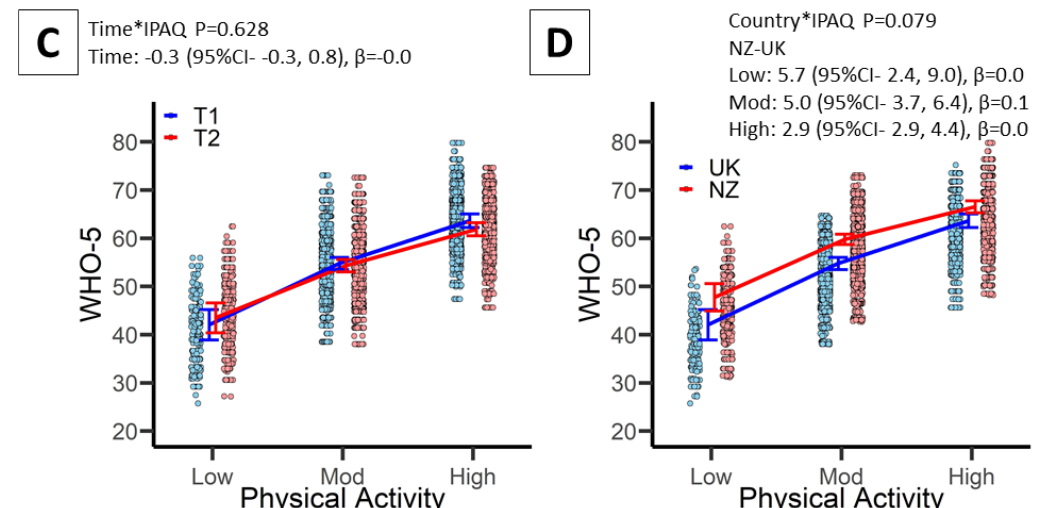
Figure 1. Associations between subjectively measured physical activity (IPAQ-SF) with mental health (DASS-9) and well-being (WHO-5). Data presented are linear mixed-effects model estimates, corresponding to model 4 described in the statistical analyses section. ( A ) Association between IPAQ-SF and DASS-9 specifying the time (T2-T1) by IPAQ interaction term; ( B ) association between IPAQ-SF and DASS-9 specifying the country (NZ-UK) by IPAQ interaction term; ( C ). association between IPAQ-SF and WHO-5 specifying the time (T2-T1) by IPAQ interaction term; and ( D ) association between IPAQ-SF and WHO-5 specifying the country (NZ-UK) by IPAQ interaction term. Data points = 6728 (1333 UK * 2 time points, 2030 NZ * 2 time points). Abbreviations: CI, Confidence interval; DASS-9, Depression, Anxiety and Stress Scale; IPAQ-SF, International Physical Activity Questionnaire-Short-Form; Mod, Moderate; NZ, New Zealand; UK, United Kingdom; T1, Timepoint 1; T2, Timepoint 2; WHO-5, World Health Organisation-5 Well-being Index.